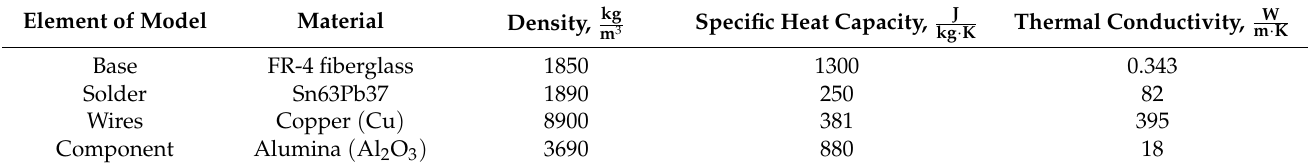
Table 2. Properties of the solid materials used.